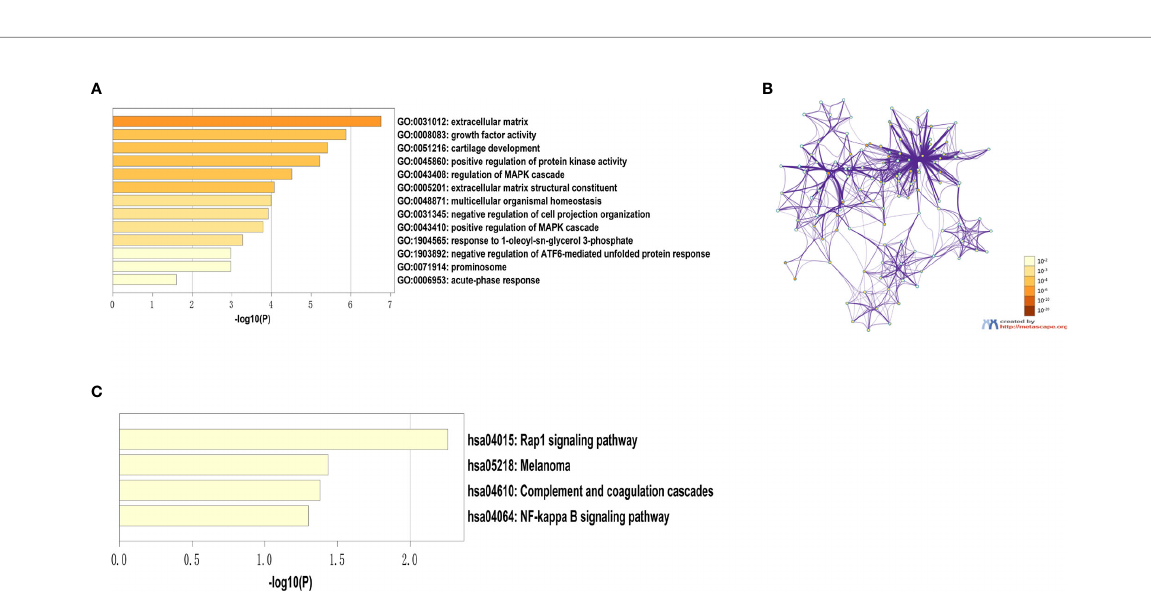
Frontiers in Oncology |